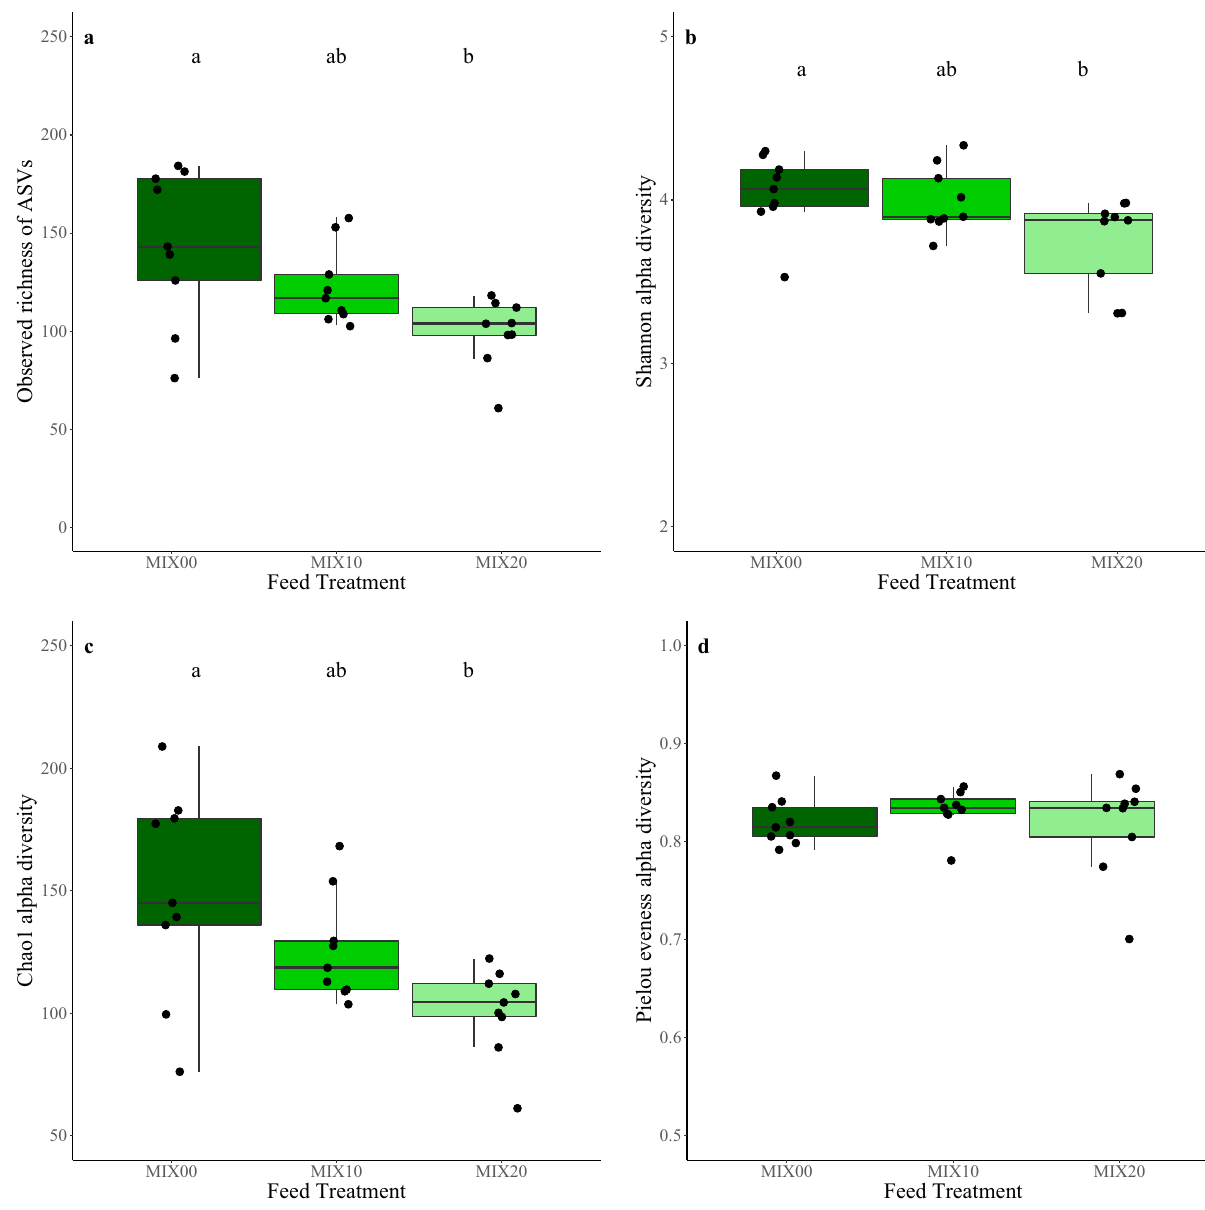
Figure 3. Box plots of alpha diversity measures for the MIX feed treatments ( a) the observed richness of ASVs, ( b) Shannon diversity, ( c) Chao1 diversity, ( d) Pielou’s evenness. Different lowercase letters indicate significantly different means (P <